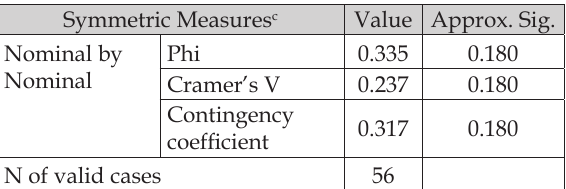
Table 4. Contingency